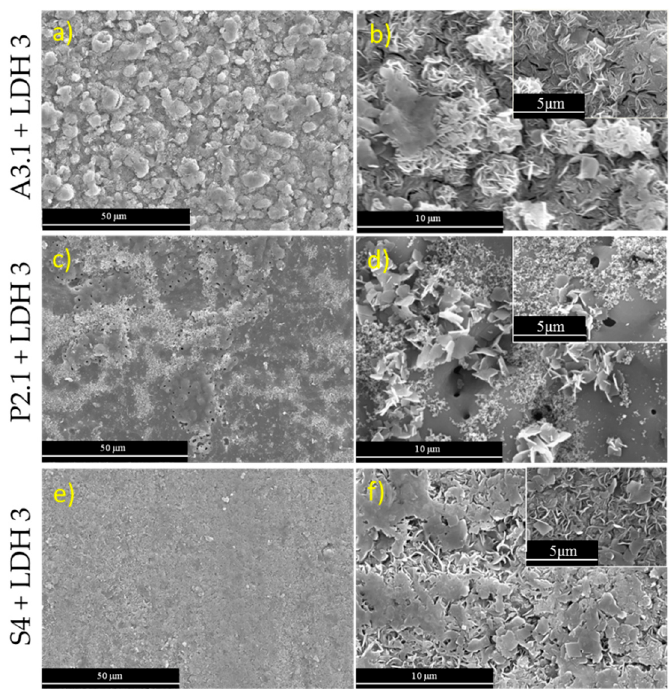
Figure 8. Secondary electron images of the planar view of the PEO coatings after LDH 3 coating formation: ( a , b ) A3.1, ( c , d ) P2.1, ( e , f ) S4.